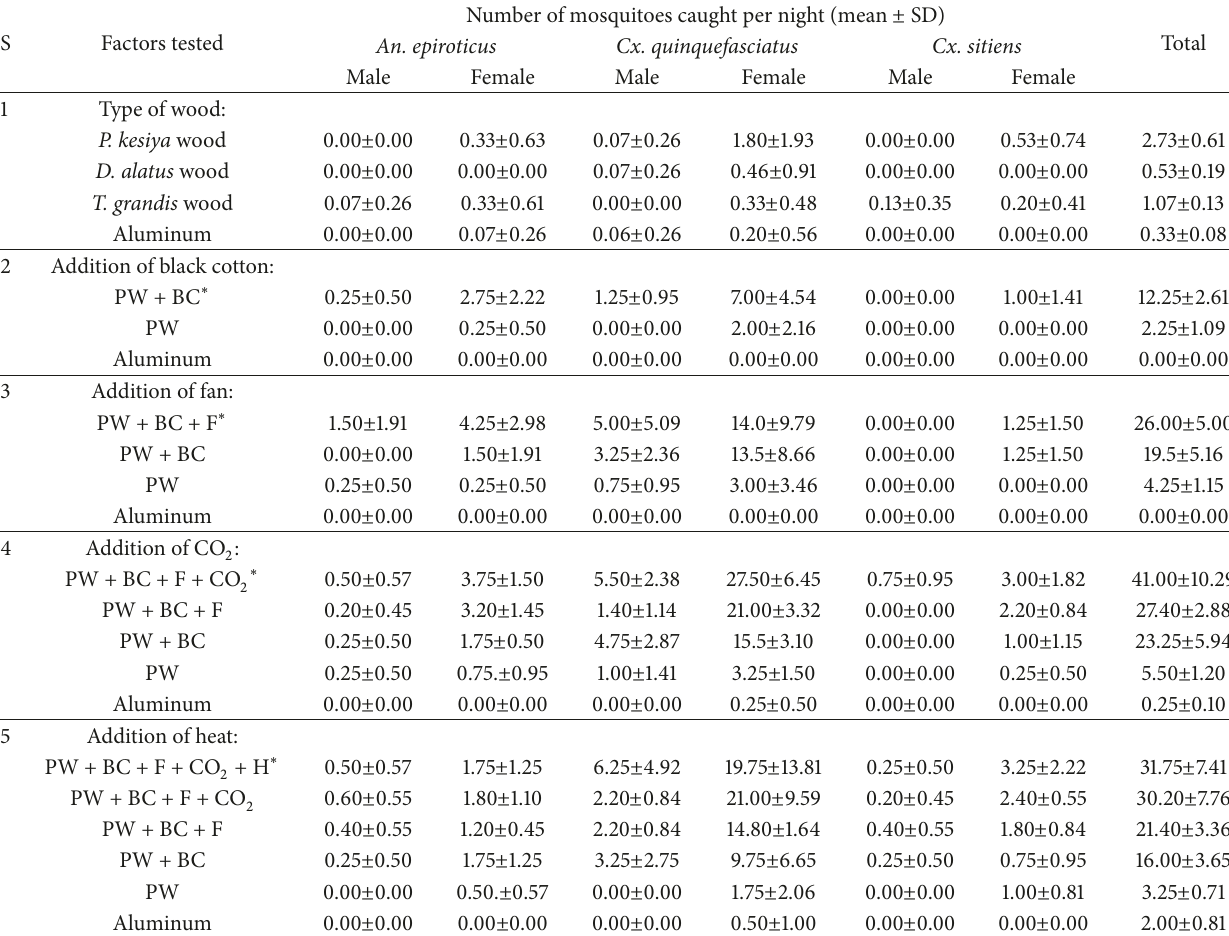
Table 1: Mean number of mosquitoes caught by each type of trapping box in steps of